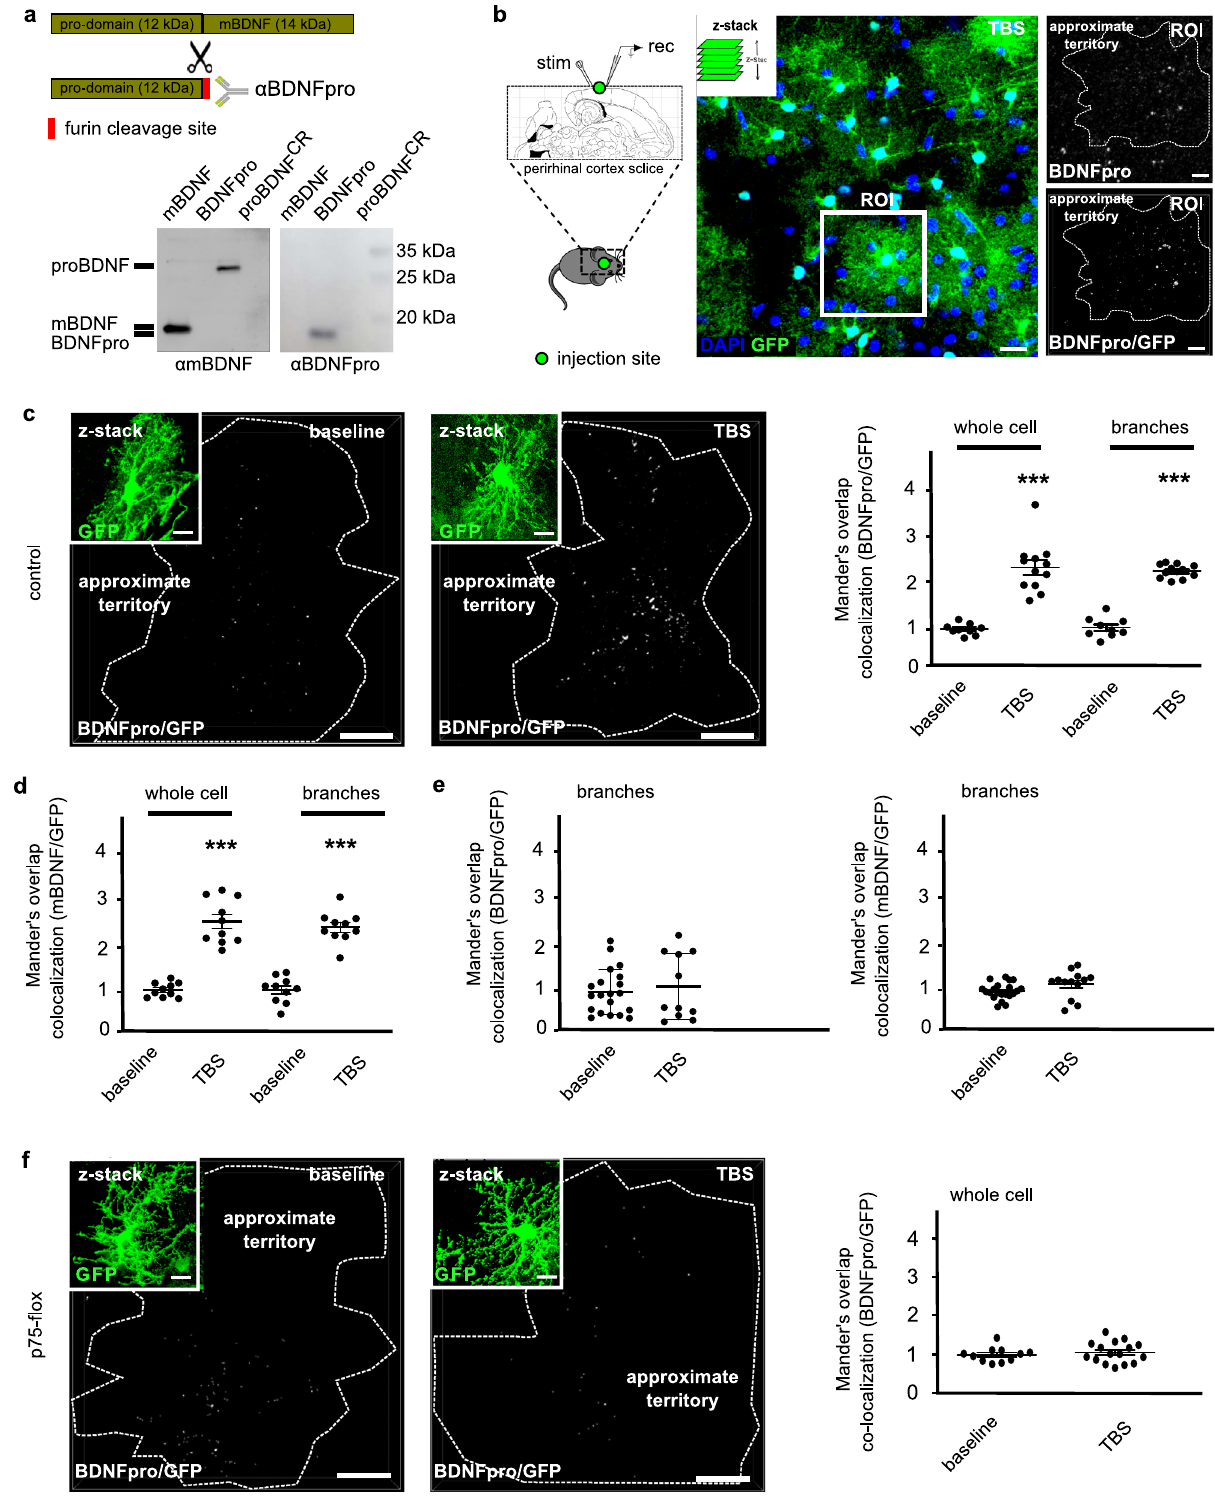
extracellular accumulation of its proteolytic products, suggests that proBDNF, but not BDNFpro and mBDNF, is selectively inter- nalized by astrocytes. Second, we performed experiments in transgenic mice in which proBDNF uptake by astrocytes is prevented by deletion of p75 NTR , its carrier receptor 16 . These mice (from here on, p75- fl ox) were generated by crossing loxP-p75 NTR - loxP mice 27 with GLAST-CreER T228 and Rosa-CAGloxP-stop-